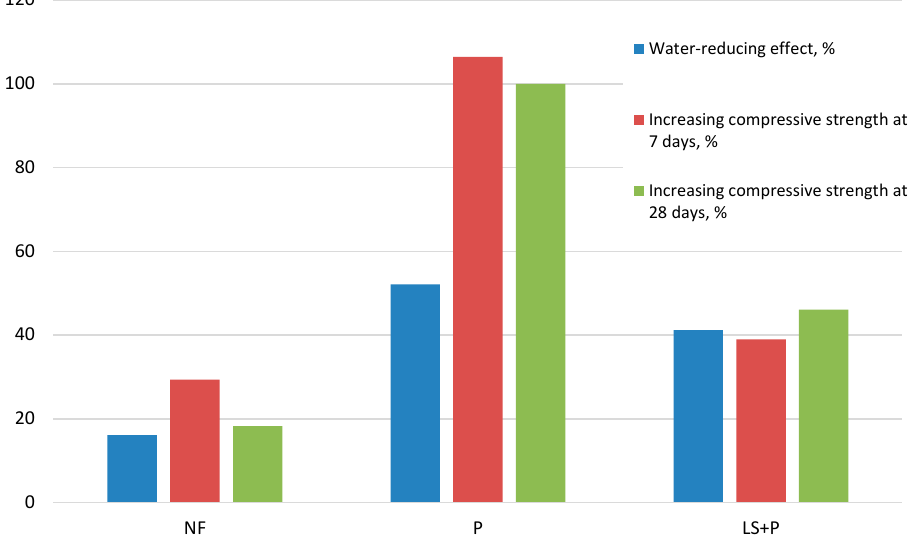
Figure 5. Comparative diagram of water-reducing effect and effect of increasing compressive strength at 7 and 28 days caused by SP.